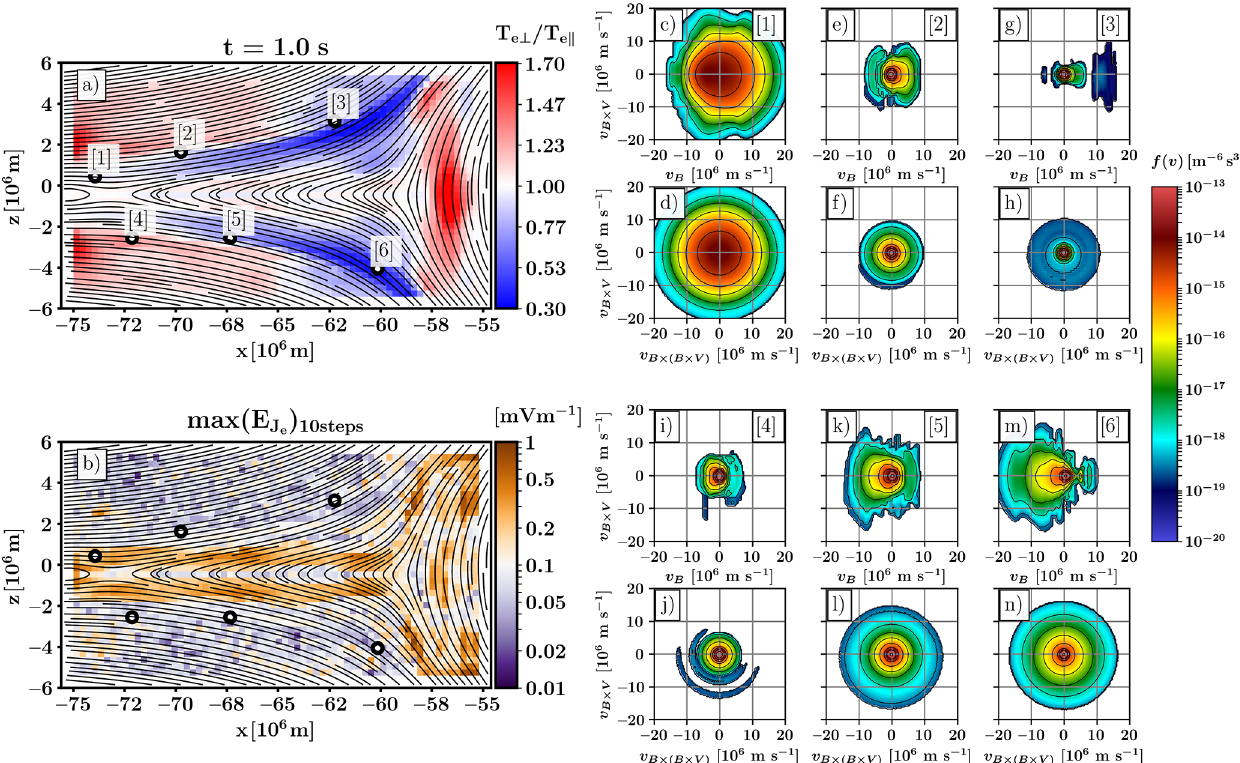
Figure 7. Electron properties and velocity distribution functions after 1 . 0s of simulation. (a) Electron temperature anisotropy T ⊥ , e T − 1 (cid:107) overlaid with magnetic field lines and six virtual spacecraft locations, labelled [1]–[6]. (b) Maximum value for displacement current E J taken over 10 measurements at 0.05s intervals near the end of the simulation. (c–n) Electron velocity distribution function projections into the parallel v B and v V × B or perpendicular v B × ( B × V ) and v V × B planes. Each virtual spacecraft is indicated by the number in the parallel eVDF panel with the panel below showing the corresponding perpendicular eVDF for the same virtual